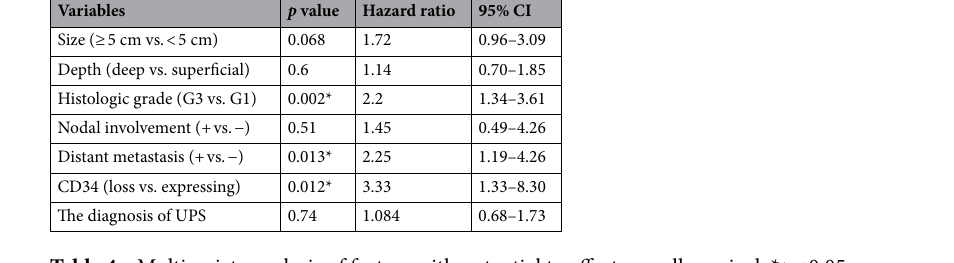
(Supplementary Fig. S1B, Supplementary Table S2) and multivariate analyses (Supplementary Table S3). Influence of CD34 status on the prognoses of patients who developed postoperative local recurrence or distant metastasis. Forty-three and 35 of 171 patients without preoperative metastatic lesions developed local recurrence and distant metastasis, respectively; eight patients developed both. Among patients with local recurrence and/or distant metastasis, those who were CD34-positive showed a significantly better overall survival than did those who were CD34-negative ( p = 0.004, Supplementary Fig. S2).